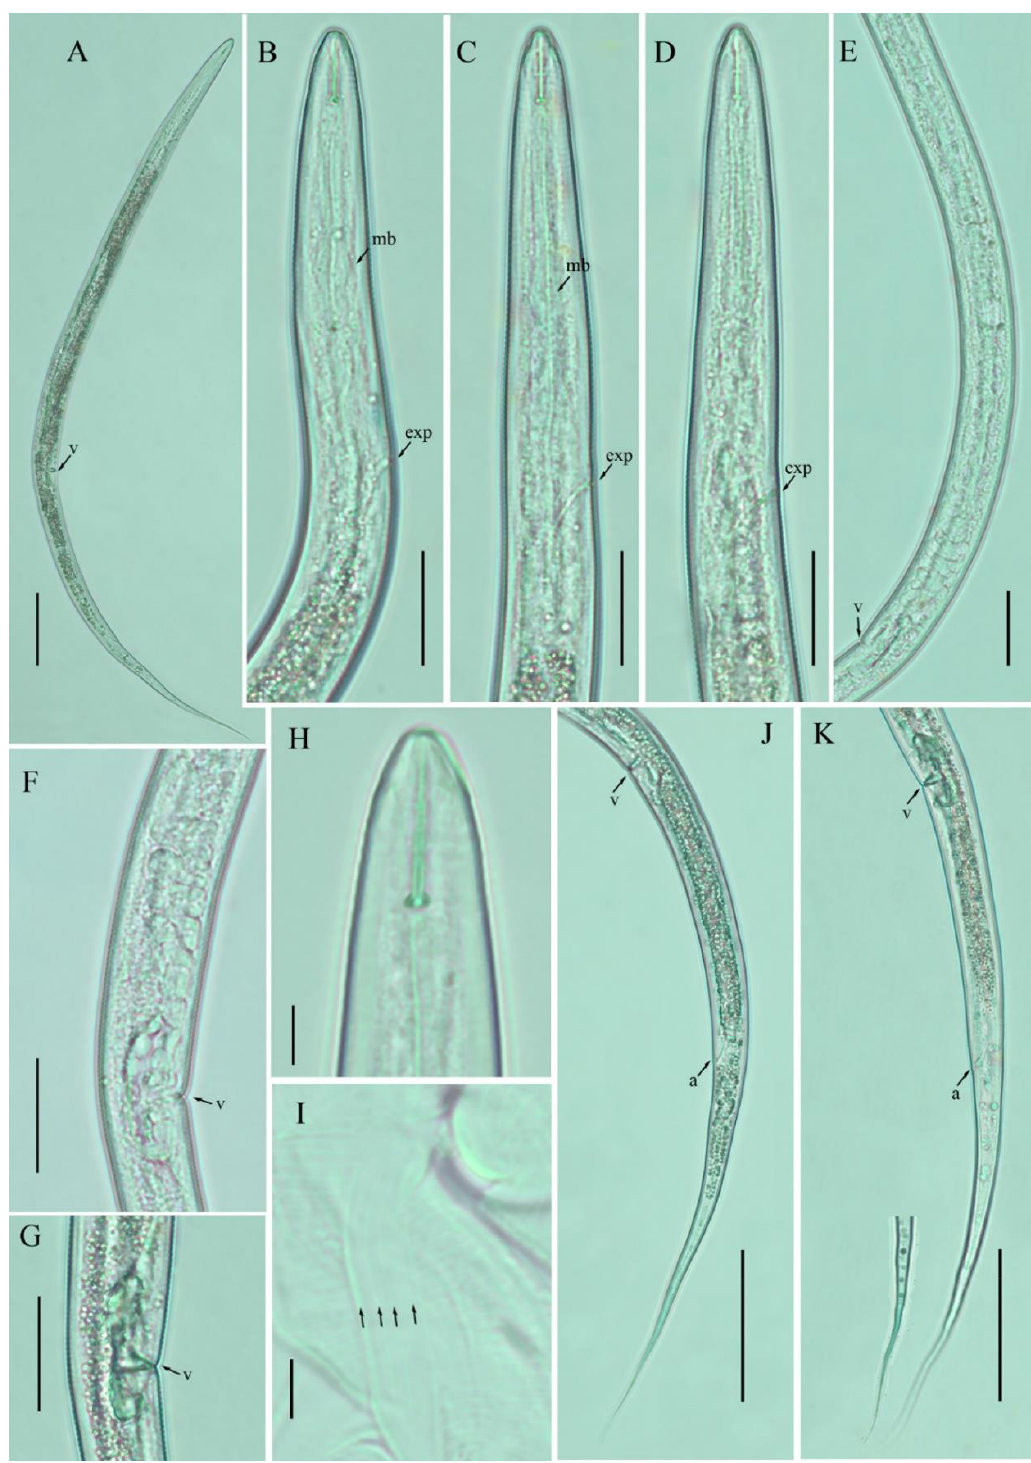
Figure 2. Photomicrographs of female Filenchus hazenensis (Wu) Andrássy [16,20]. ( A ) Entire body; ( B – D ) pharyngeal regions; ( E ) gonad; ( F , G ) vulval region; ( H ) lip region; ( I ) lateral lines; ( J , K ) posterior body to tail terminus. Scale bars: ( A ) 50 µm; ( B – G , J – K) 20 µm; ( H , I ) 5 µm. Arrowheads: (a) anus; (exp) excretory pore; (mb) median bulb; (PUS) post-uterine sac; (v) vulva.